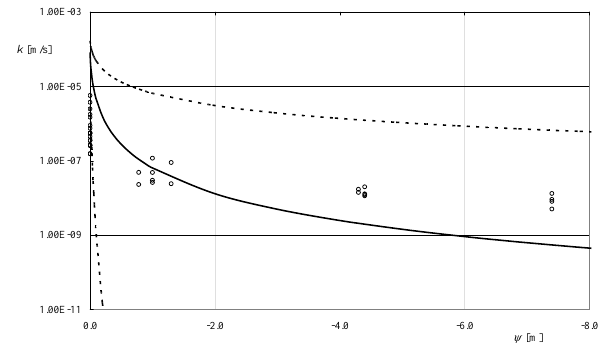
Figure 5 Fig. 5. Hydraulic conductivity curve: dots represent laboratory ex- perimental data over samples of ashes (layer B); the bold line is the calibrated hydraulic conductivity curve of the assumed single ho- mogeneous layer; the dashed lines represent the limits of the range of hydraulic conductivity curves considered in the calibration pro- cedure.